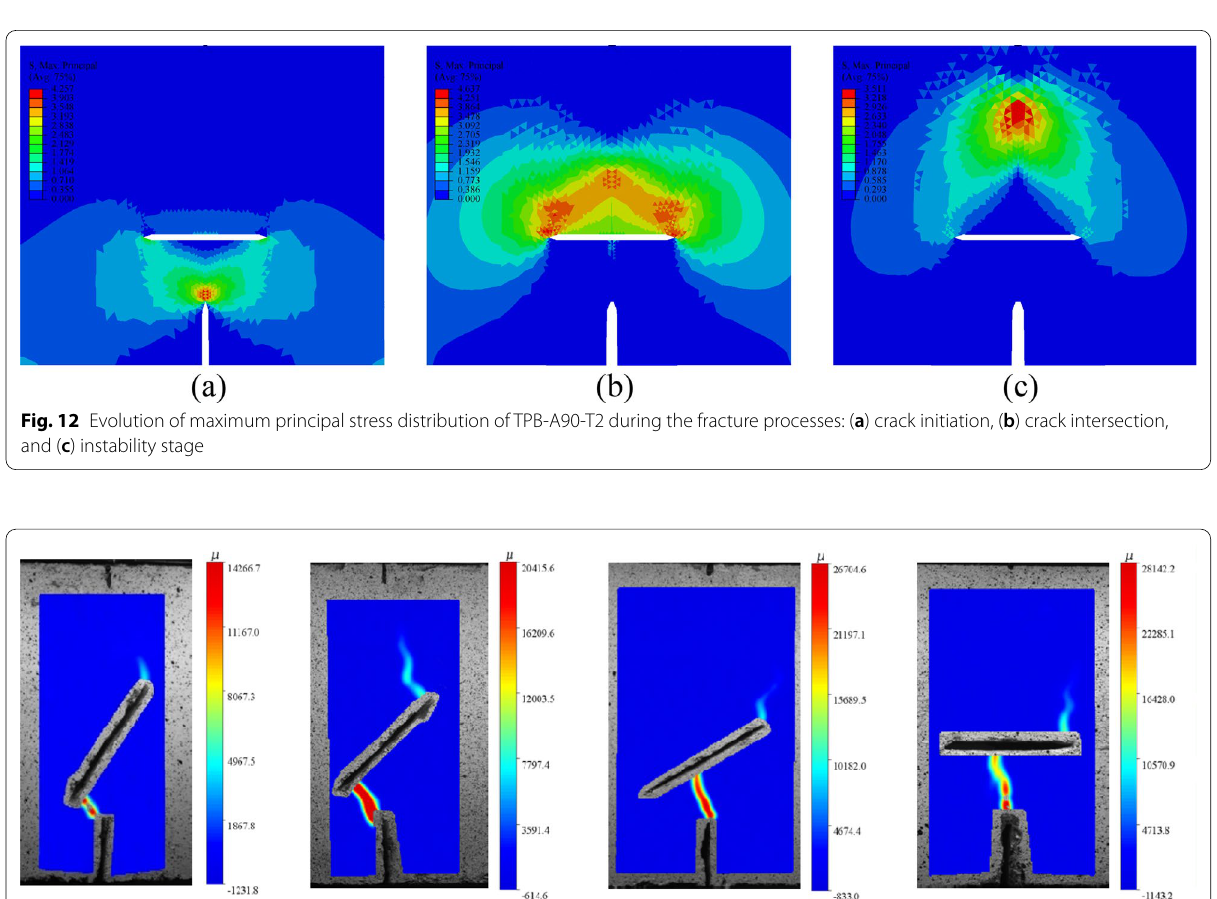
30°, ( b ) θ 45°, ( c ) θ 60°, and ( d ) θ 90° at the loading rate of = = = =